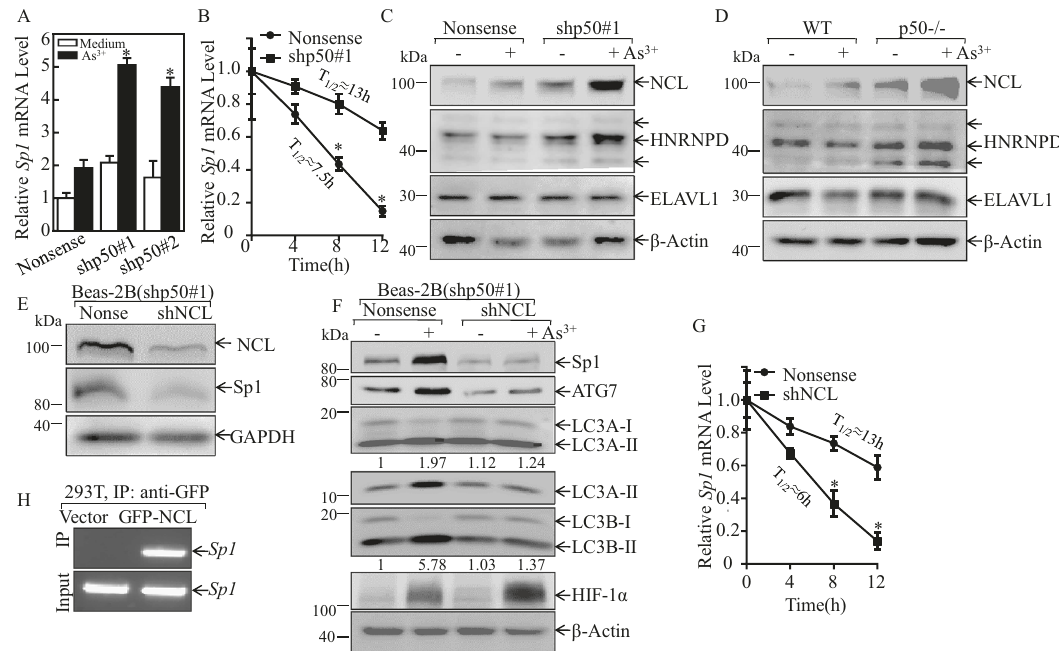
Fig. 5 p50 impaired Sp1 mRNA stability by inhibiting NCL expression upon arsenite treatment. A Beas-2B(Nonsense) and Beas-2B(shp50) cells were exposed to 20 μ M arsenite and Real-Time PCR assay was performed to evaluate the Sp1 mRNA expression; The symbol (*) indicates a signi fi cant increase as comparison to Beas-2B(Nonsense) cells treated with arsenite ( p < 0.05). B In the presence of actinomycin D (RNA synthesis inhibitor, 10 mM), Sp1 mRNA degradation rates in transfectants of Beas-2B(Nonsense) and Beas-2B(shp50) were determined for the indicated time periods. C , D WT, p50 − / − , Beas-2B(Nonsense), and Beas-2B(shp50) cells were treated with 20 μ M arsenite for 24 h. The cell lysates were subjected to western blot. E , F shRNA NCL was stably transfected into Beas-2B(shp50#1) cells. The indicated stable transfectants were treated with or without arsenite for 24 h; and cell extracts were subjected to Western blot for determination of indicated protein expression, the ratio of LC3 II/LC3 I was quanti fi ed. G Sp1 mRNA degradation rates in the indicated cell transfectants were evaluated in the presence of 10 mM actinomycin D (RNA synthesis inhibitor) for the indicated time periods. H 293 T cells was transfected with GFP-NCL construct and the cell extracts were subjected to GFP-NCL protein pulled down assay by using anti-GFP beads. RT-PCR was carried out to determine the Sp1 mRNA bound to NCL